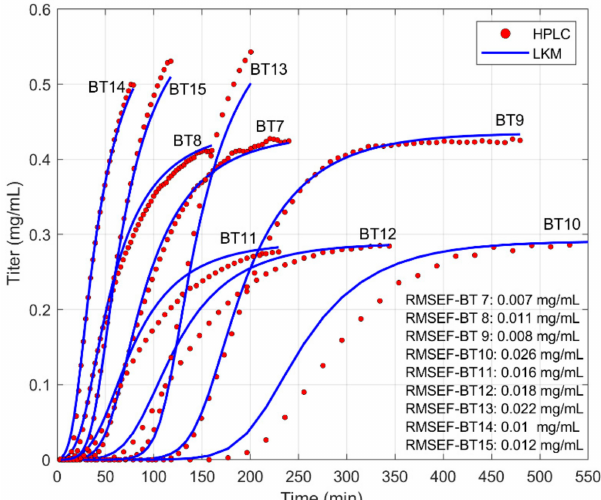
Figure 6. Mechanistic model (LKM) predictions of titer for BT# 1–6 with parameter values fitted on BT# 7–15 (blue) compared to HPLC o ff -line measurements